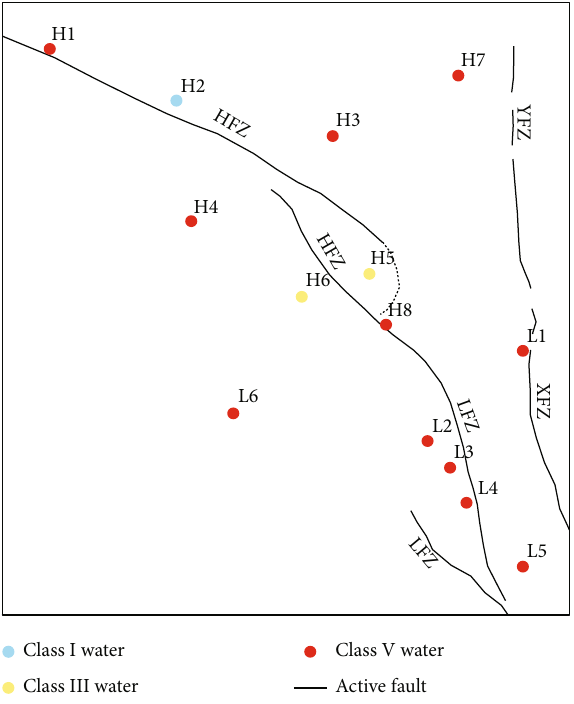
Figure 3: Voronoi diagram of water quality grade in